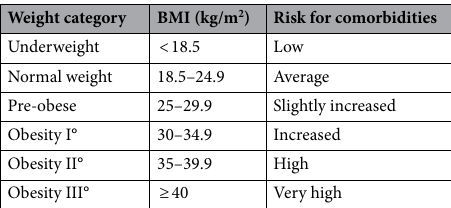
Table 1. WHO definition for